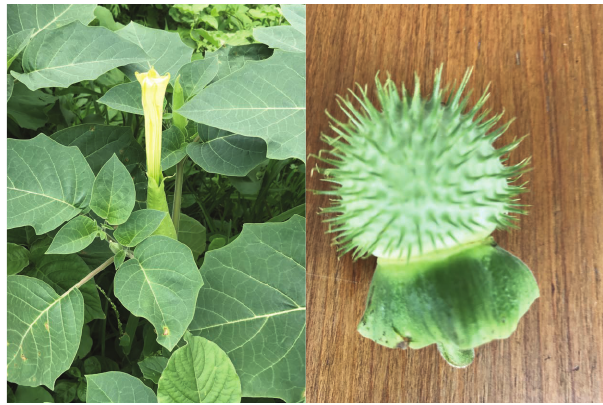
Figure 1. The leaves, flower and fruit of datura inoxia .